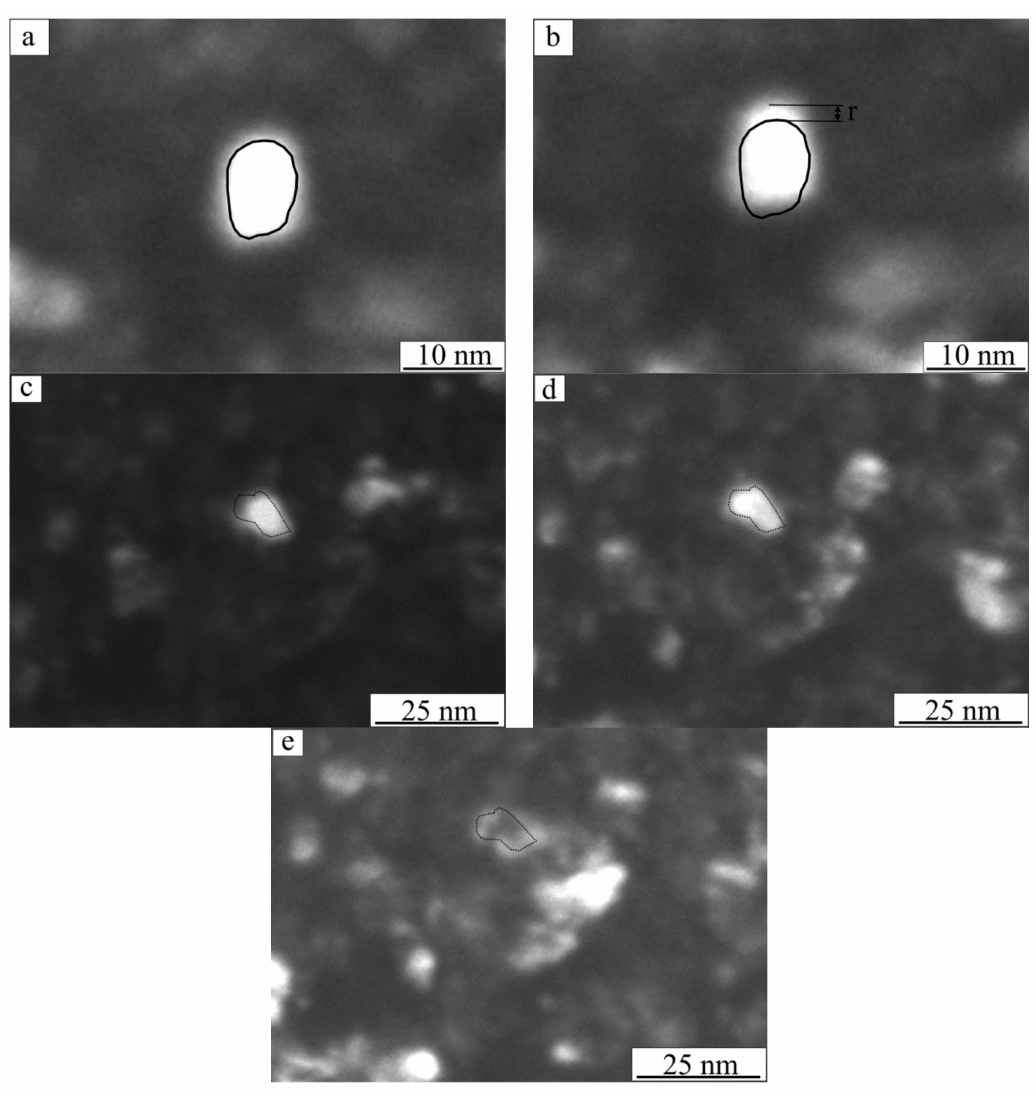
Figure 12. Dark-field images of extinction contour movement that reflected the high values and nonuniformity of crystal lattice bending near the crystal boundaries ( a , b : a —sample tilt an- gle 0 ◦ , b —sample tilt angle 0.5 ◦ ) and misorientation of the central and periphery of the crystals ( c – e : c —sample angle tilt 0 ◦ , d —sample angle tilt 0.5 ◦ , e —sample angle tilt 1 ◦ ) (see explanation in